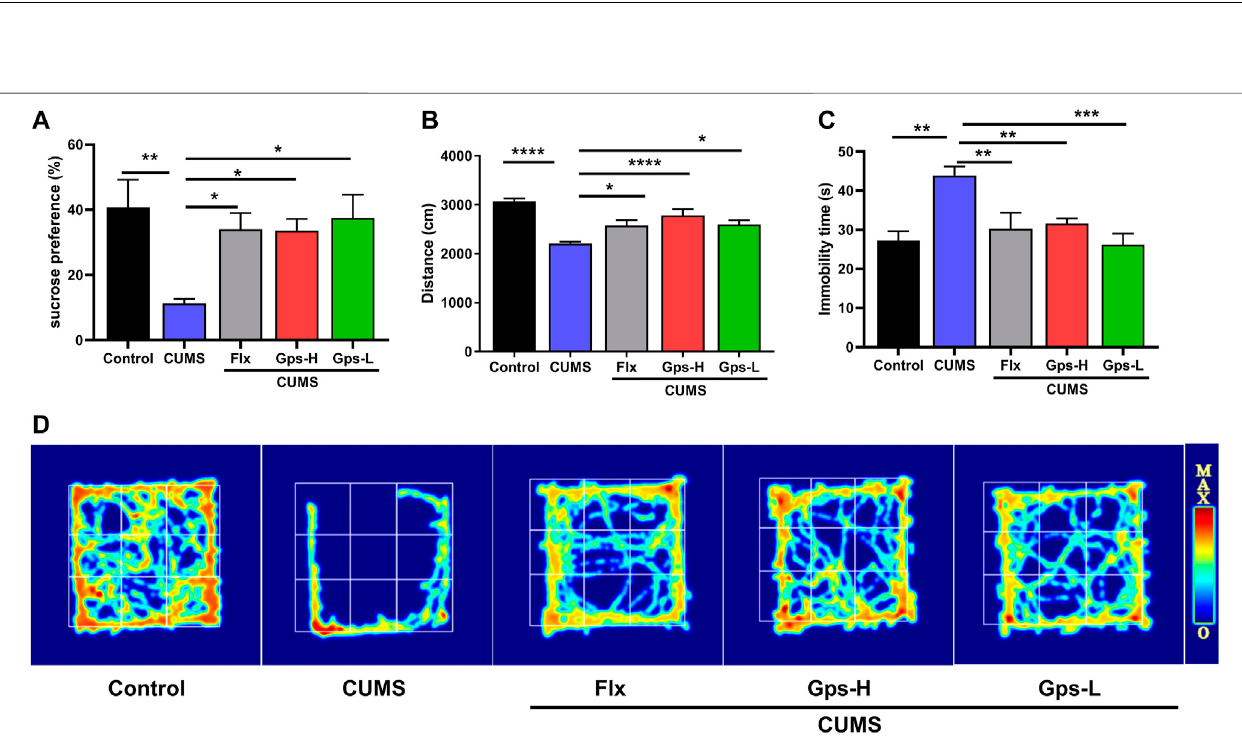
Frontiers in Pharmacology |